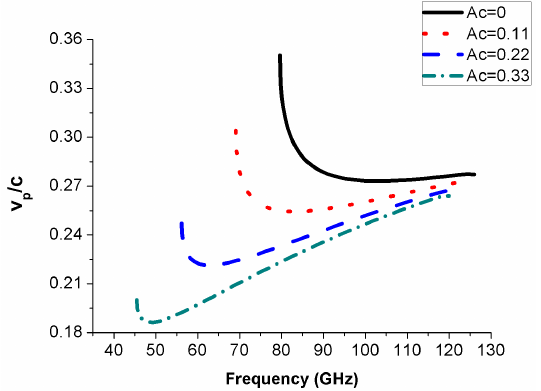
Figure 2. Normalized phase velocity of the CV-FWG for various values of Ac.